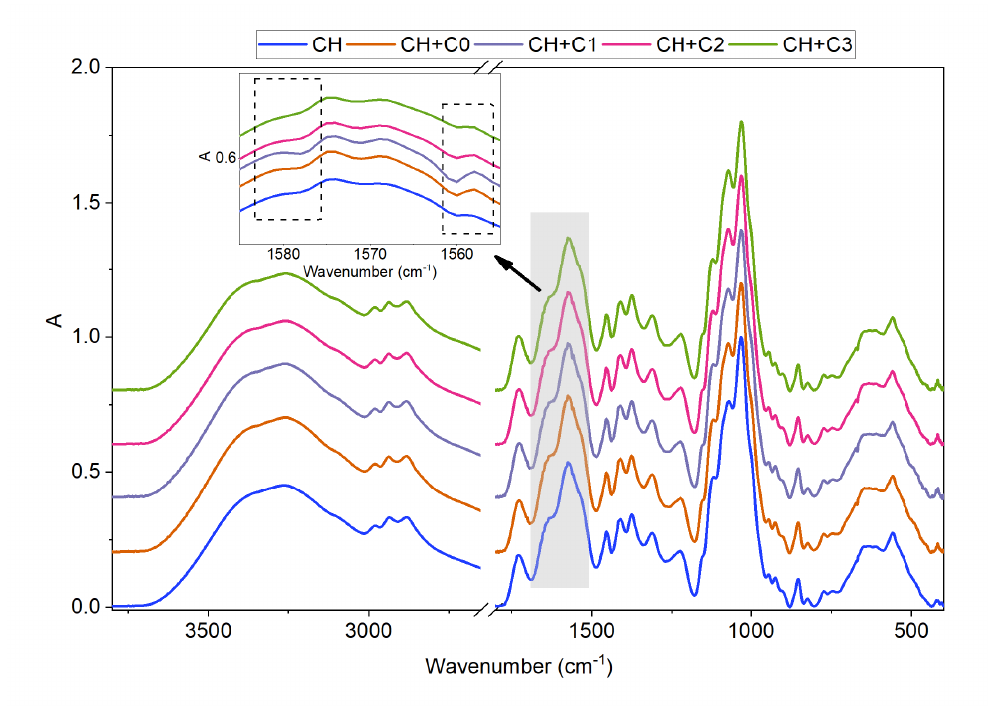
Figure 4. FTIR–ATR analysis of chitosan-based films with and without integrated CNCs of various DS. Alginate, also a linear co-polymer, is made of β -D-mannuronate and α -L-guluronate, which are linked by β -1,4 and α -1,4 glycosidic bonds. In Figure 5a, full spectra of the samples are presented, and Figure 5b–f exhibit the fragments of the spectra where changes upon integration of pristine and modified CNCs occur. The blue line denotes the characteristic spectrum of ALG. A broad peak between 3700 cm − 1 and 2980 cm − 1 , correlated to -O-H stretching, decreases in intensity, first slightly upon the incorporation of C0, and then further with the acetylation of CNCs. The peaks located between 2980 cm − 1 and 2880 cm − 1 are related to the asymmetric and symmetric stretching modes of -CH 2 - [39], and the wear peak centred at 2938 cm − 1 is related to -CH- stretching (Figure 5b). Although the shape of the peak remained the same when incorporating pristine CNCs, the original bonds were disturbed by acetylated CNCs, whereas the peaks for -CH 2 - stretching shifted to lower wavenumbers, which points to a weakening of the bond [39], and the peak correlated with -CH- stretching disappeared. In the region between 1770 cm − 1 and 1710 cm − 1 , Figure 5c, a peak corresponding to -C=O- stretching vibrations in acetylated CNCs emerges in samples ALG+C1, ALG+C2 and ALG+C3. Its intensity, however, is inversely proportional to the DS of CNCs. This could be attributed to the better integration of CNCs with lower DS in the alginate matrix, while a higher degree of acetylation leads to the aggregation of CNCs. Indicating the presence of cellulose, the peaks at 1335 cm − 1 (related to -OH- bending) and 1160 − 1 (related to -C-O- stretching) can be observed in Figure 5d,e in samples with incorporated CNCs but not in ALG. Lastly, the peaks centred at 1123 cm − 1 and 1086 cm − 1 (Figure 5f) ascribed to -C-C- and -C-O- stretching vibrations, respectively, became less pronounced upon the reinforcement of alginate-based films with